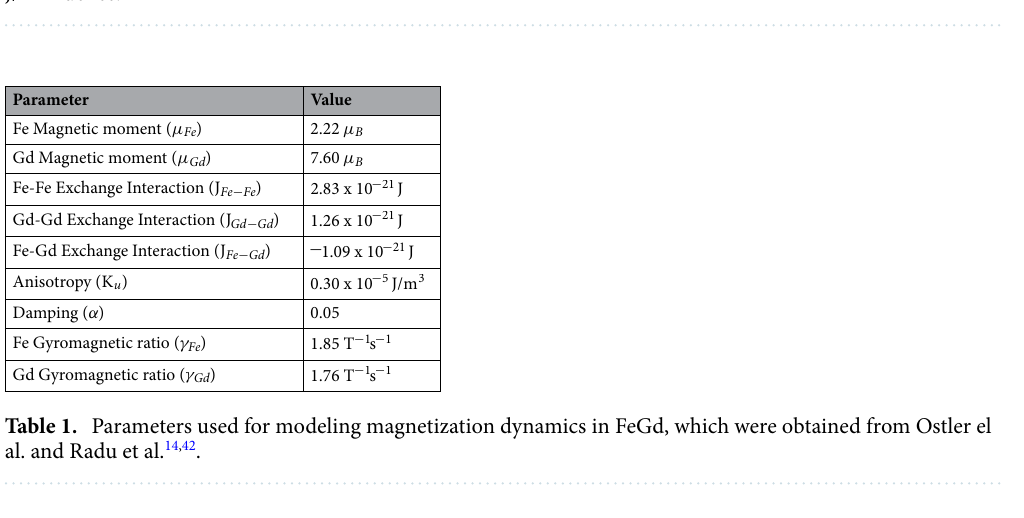
Figure 5. Temporal evolution of electron and lattice temperature after irradiation of a 100-fs laser pulse with 30 2 J/m fluence.